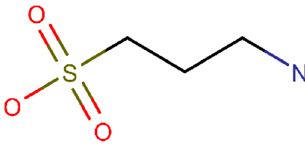
Figure 4. Chemical structure of homotaurine.